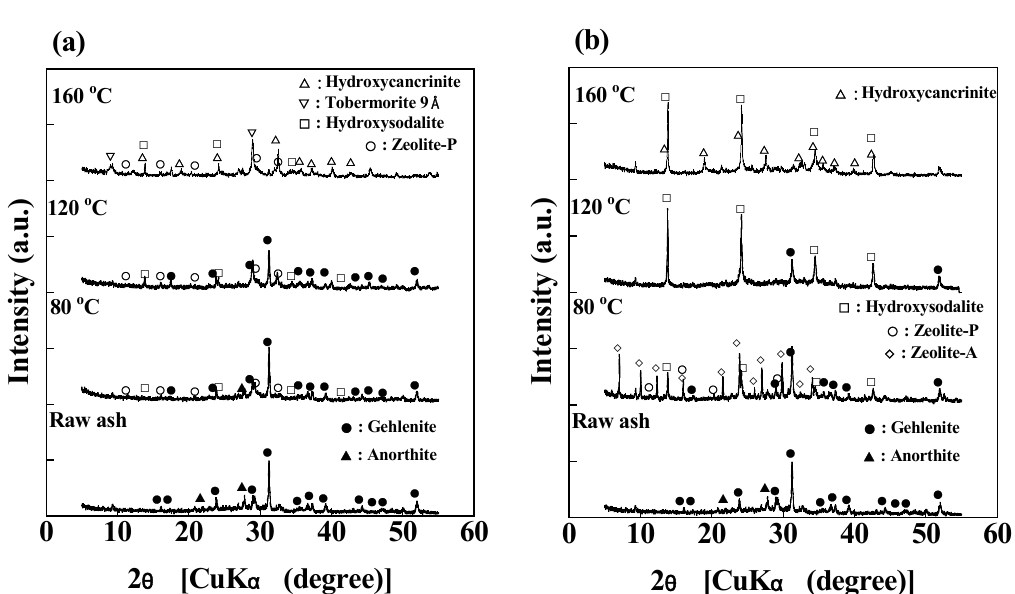
Figure 4. XRD patterns of the products synthesized at 80, 120, and 160 ◦ C: ( a ) without 1 M EDTA and ( b ) with 1 M EDTA (NaOH concentration: 3 M NaOH, Reaction time: 24 h).